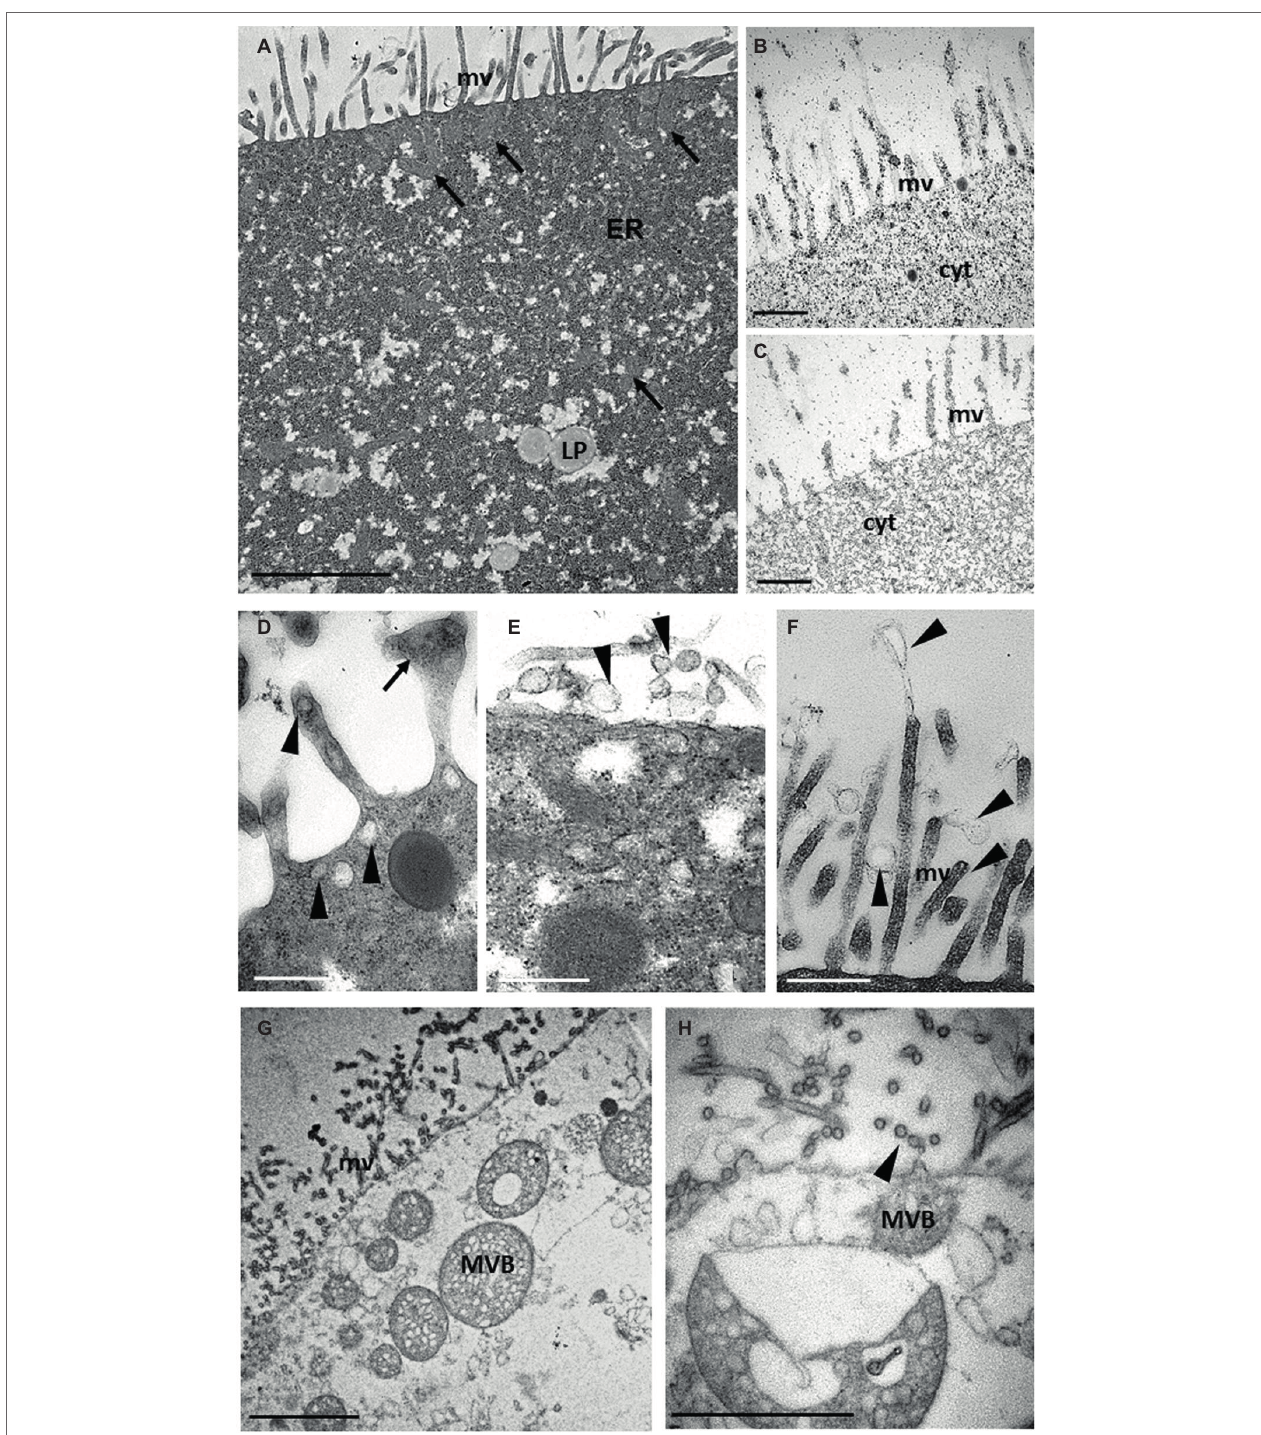
FIGURE 3 | TEM ultrastructural analysis of teratocytes intracellular structures. A thick layer of microvilli (mv) covers the plasma membrane. Numerous mitochondria (arrows) are present under the coat of microvilli (arrows). Lipid droplets (LP) and abundant rough endoplasmic reticulum (ER) are visible in the cytoplasm (A) . Glycogen granules black stained by Thiery reaction are visible in the cytoplasm (B) . No black staining is detected in control sections (C) . Secretory vesicles (arrowheads) are visible in close proximity of the plasma membrane and of microvilli, some of which showing an enlarged tips (arrow) (D) . Secretory exosome-like structures (arrowheads) emanating from the plasma membrane (E) and from microvilli (F) can be observed. Multivesicular bodies (MVB) like structures having a single limiting outer membrane and containing internal vesicles of homogeneous size are visible in close proximity of plasma membrane (G) . Detail of a MVB exocyting exosome-like structures (arrowhead) (H) . Bars in (A,G) : 2 μm; bars in (B–F) : 500 nm; bar in (H) : 1